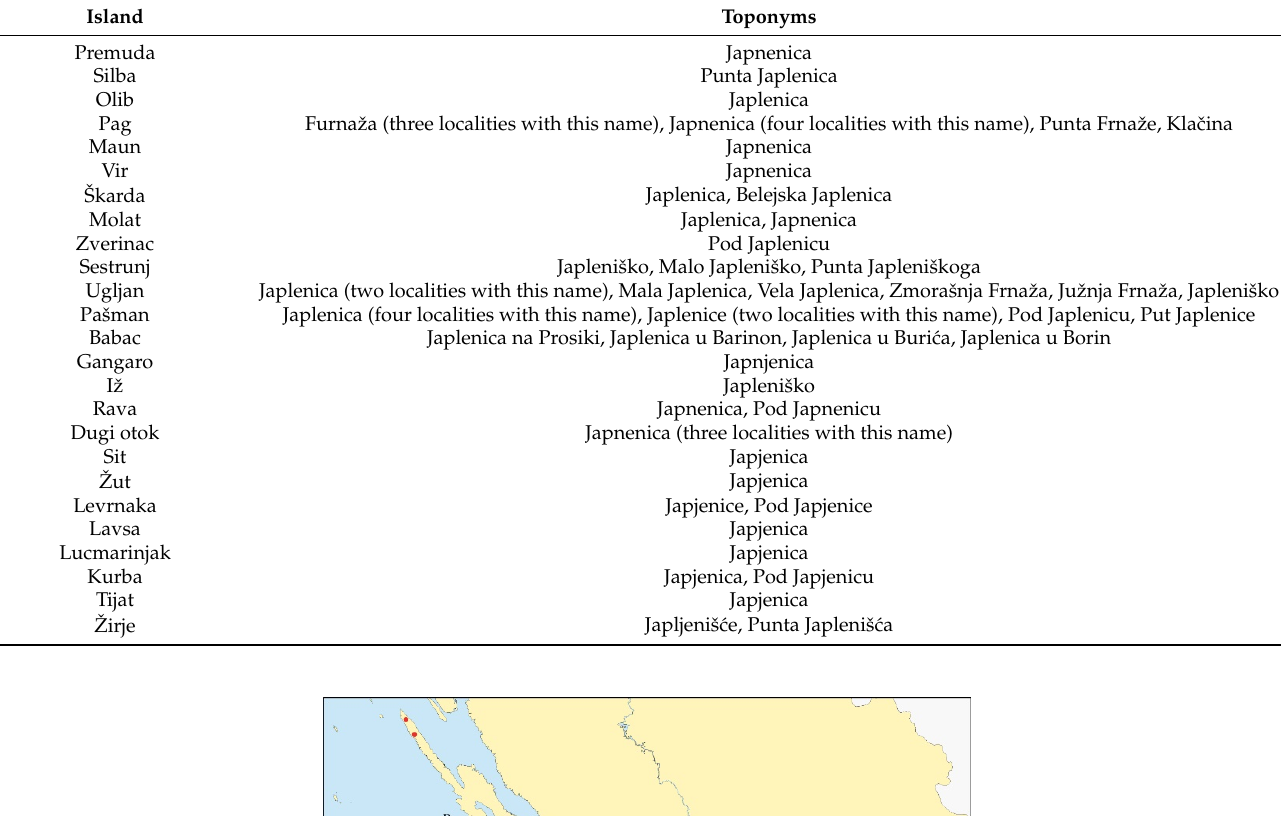
Table 2. Toponyms connected with lime production in today’s linguistic landscape of the northern Dalmatian islands (the islands are listed from northwest to southeast) [79–87].